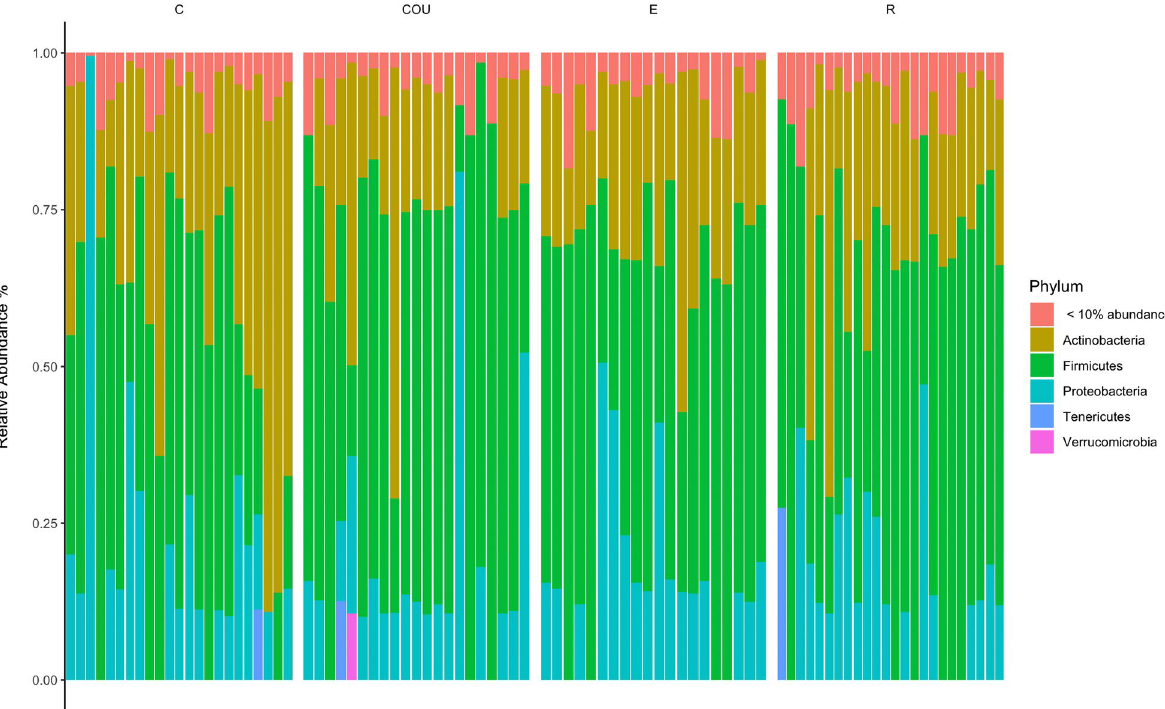
Fig. 2 Bacterial relative abundances on Phylum level across the four treatment groups. Each bar represents an individual sample. Treatment groups are control (C), unmanipulated control (COU), enlarged (E), and reduced (R). N COU 21, E 20, R 24. Phyla with less that 10% in relative abundance is collapsed into the category “< 10% = = =